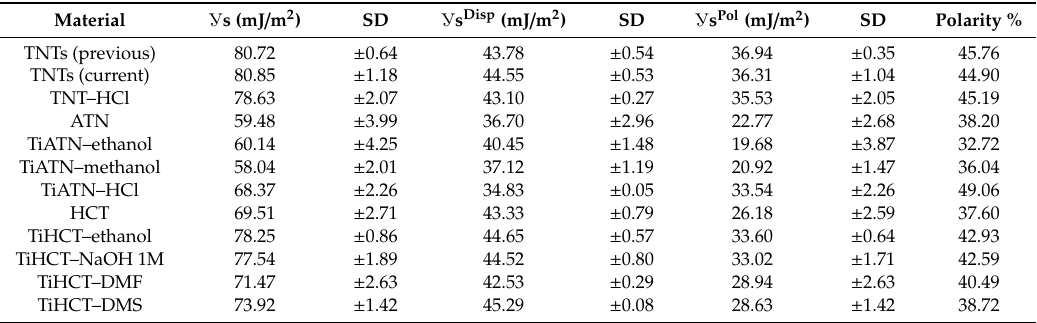
Figure 1. TEM ( a , c ) and SEM ( b , d ) micrographs of TNTs ( a , b ) and TNT–HCl 0.01 M ( c , d ). Table 2. Surface free energy and polarity of TNTs, atenolol (ATN), hydrochlorothiazide (HCT), and their